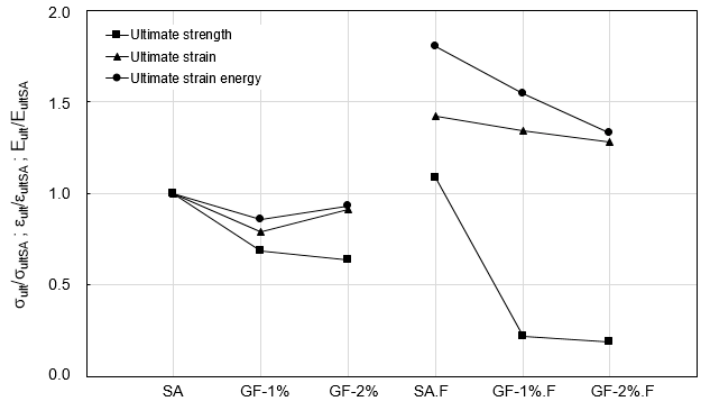
Figure 14. Evolution of the mean values associated with the ultimate strengths and strains from compressive strength testing, in test pieces before and after direct fire testing.